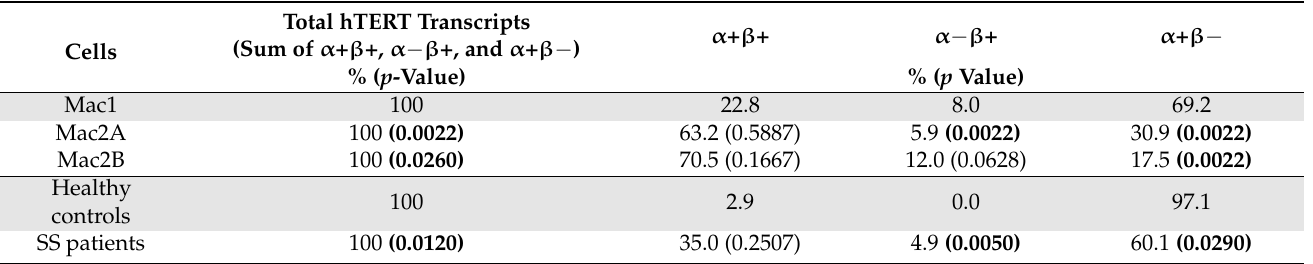
Table 3. hTERT transcripts expression level comparing indolent and aggressive phases in Mac cell lines, and also SS patients to healthy